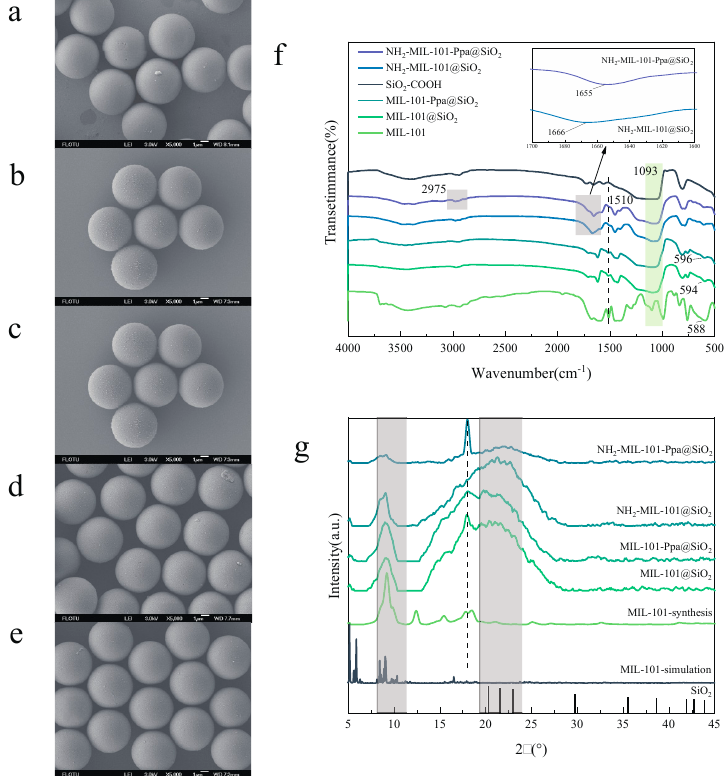
Figure 1. The SEM images of SiO 2 − COOH ( a ), MIL − 101@SiO 2 ( b ), MIL − 101 − Ppa@SiO 2 ( c ), NH 2 − MIL − 101@SiO 2 ( d ) and NH 2 − MIL − 101 − Ppa@SiO 2 ( e ); the FT-IR spectra of SiO 2 − COOH, MIL − 101@SiO 2 , MIL − 101 − Ppa@SiO 2 , NH 2 − MIL − 101@SiO 2 , NH 2 − MIL − 101 − Ppa@SiO 2 and MIL − 101 ( f ); the synthesized XRD patterns of NH 2 − MIL − 101 − Ppa@SiO 2 , NH 2 − MIL − 101@SiO 2 , MIL − 101 − Ppa@SiO 2 , MIL − 101@SiO 2 , MIL − 101 and SiO 2 − COOH; and simulated XRD pattern of MIL − 101 ( g ). preparation of MIL − 101@SiO 2 , NH 2 − MIL − 101@SiO 2 , MIL − 101 − Ppa@SiO 2 and NH 2 − MIL − 101 − Ppa@SiO 2 materials, as shown in Figure 1f. In the spectrum of SiO 2 − COOH, the peak intensity at 1093 cm − 1 was ascribed to the vibration of Si-O-Si [32]. An adsorption peak at 1510 cm − 1 in the spectrum of MIL − 101 was attributable to the asymmetric and SiO 2 − COOH and MIL − 101 could be observed in the spectrum of MIL − 101@SiO 2 , which indicated that the MIL − 101@SiO 2 composite was formed [32]. Comparing MIL − 101@SiO 2 with MIL − 101 − Ppa@SiO 2 , the peak of the Al-O stretch slightly shifted from 594 cm − 1 coupling [62]. In the spectrum of NH 2 − MIL − 101@SiO 2 , the appearance of the charac- teristic band at 1666 cm − 1 was due to the -NH 2 linkage, which proved the successful synthesis of NH 2 − MIL − 101 [63]. Evidence that NH 2 − MIL − 101 was deposited onto the SiO 2 microspheres could also be obtained from the spectrum of NH 2 − MIL − 101@SiO 2 in the same way as MIL − 101@SiO 2 . Comparing the spectrum of NH 2 − MIL − 101@SiO 2 with that of NH 2 − MIL − 101 − Ppa@SiO 2 , the characteristic peak at 2975 cm − 1 originating from the N-H bond of NH 2 − MIL − 101 was increased, suggesting that the amide